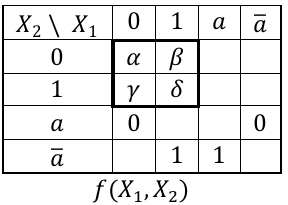
Figure 8. Function table for the function of example